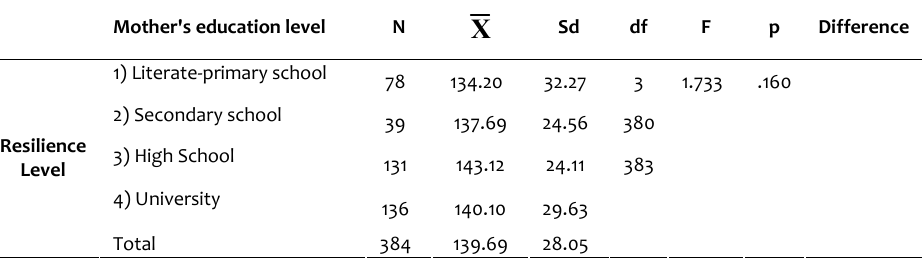
Table 5. Results of ANOVA on Resilience Levels of the 5-Year-Old Preschoolers According to Mother's Education